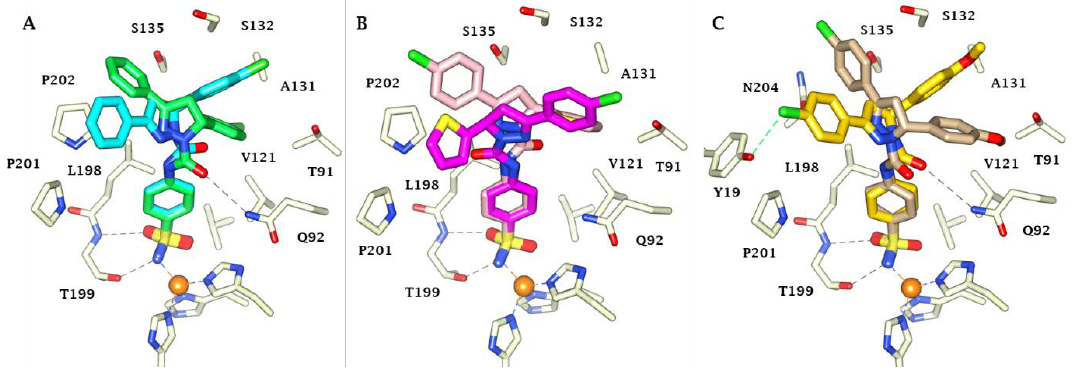
Figure 4. Docked binding orientations of ( A ) (R) -6 (green) and (S) -6 (cyan), ( B ) (R) -18 (magenta) and (S) -18 (pink), and ( C ) (R) -21 (tan) and (S) -21 (gold) to CA XII (pdb 1JD0). H-bonds are represented as dashed lines.